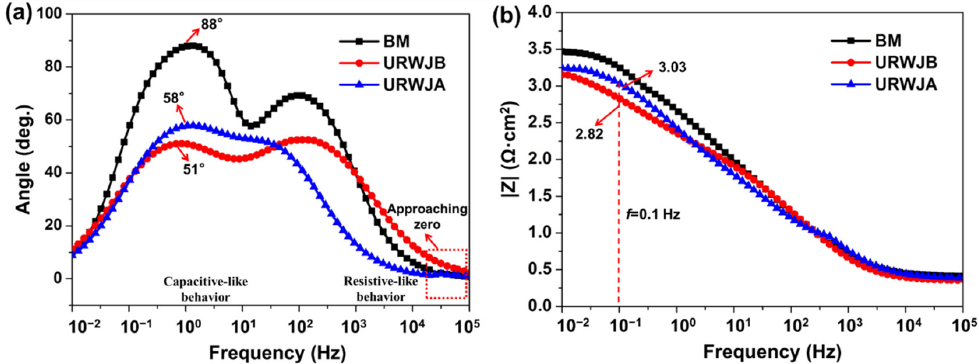
Figure 8. Bode plots of BM and URWJs: the relationship between ( a ) phase angle and log f , ( b ) log|Z| and log f .